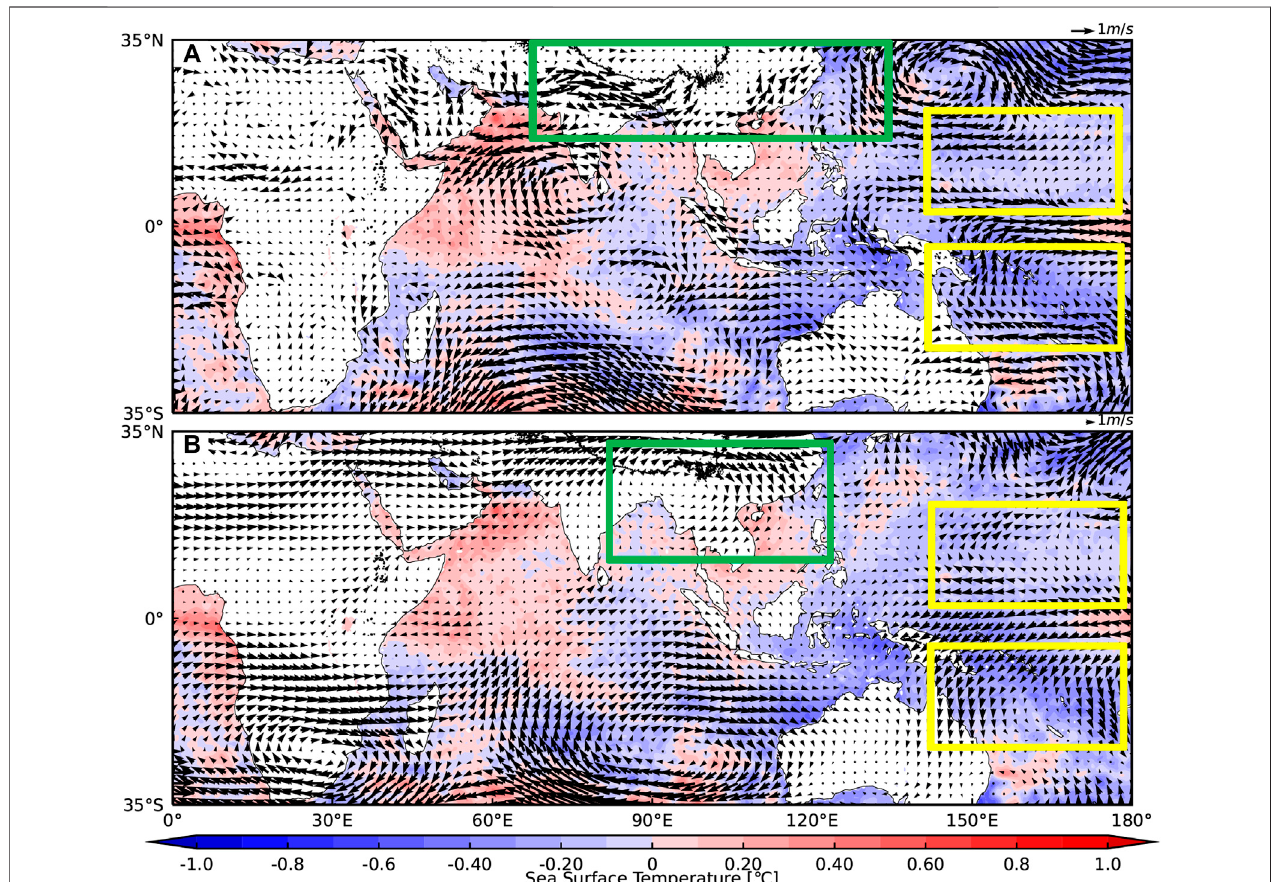
FIGURE 10 | Composite wind field in the stronger years for the EOF time series 1 (arrows, unit: m/s) and SST (shading, unit: K) at (A) 850 hPa and (B) 200 hPa.